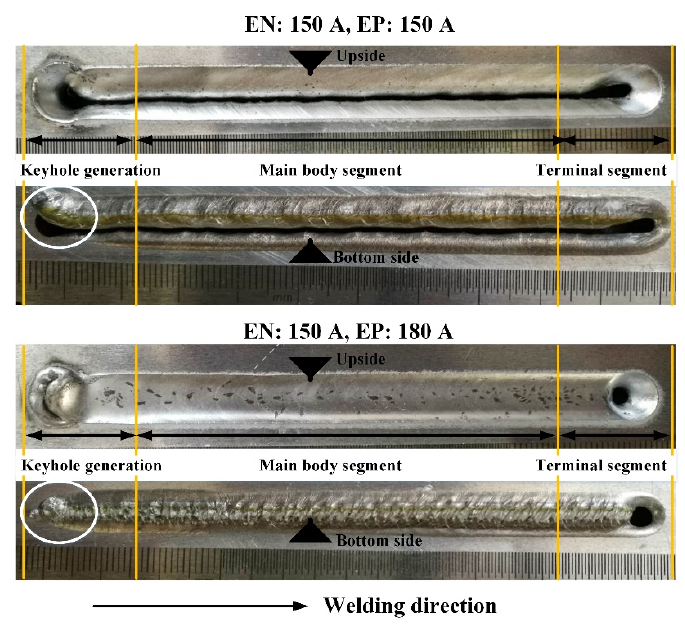
Figure 19. The weld formation with different EP current.